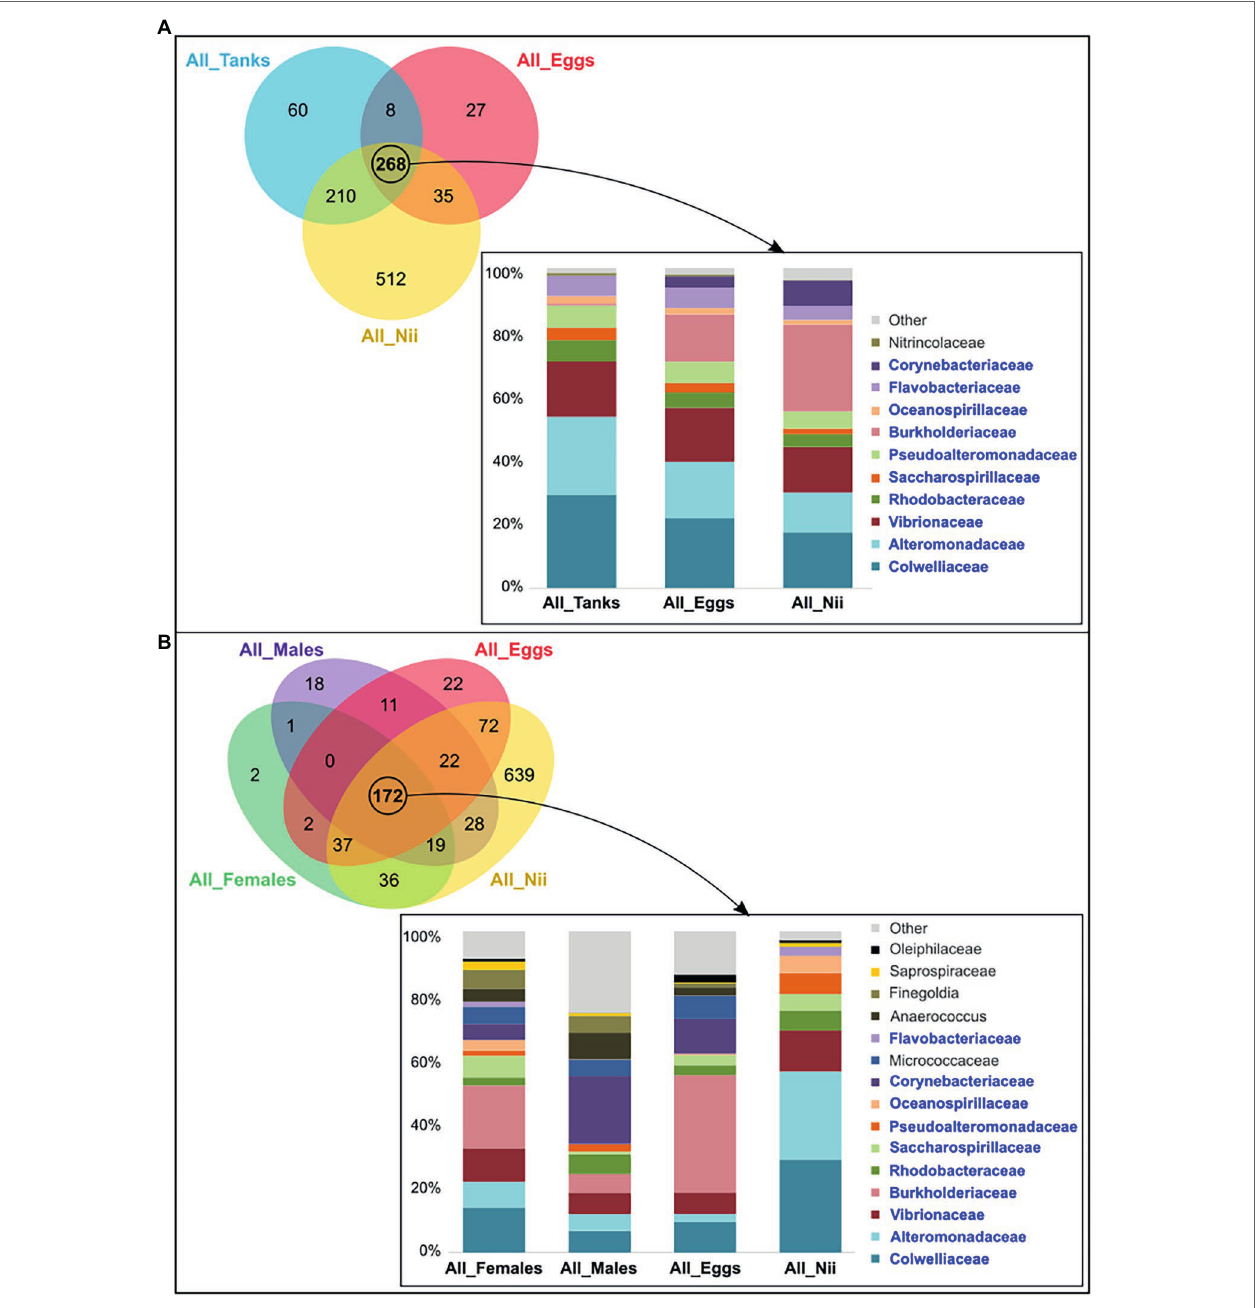
FIGURE 4 | Shared bacterial lineages among the eggs, the nauplii, the tank waters, and the reproductive organs of the breeders. Top bacterial families with a total relative abundance higher than 1% shared among (A) the tank water, the egg, and the nauplius (nii) samples (268 ASVs) and (B) the female and the male reproductive organs, the egg and the nauplius (nii) samples (172 ASVs). The bacterial families in blue are those shared between the two histograms which were constructed by averaging the triplicates for each sample